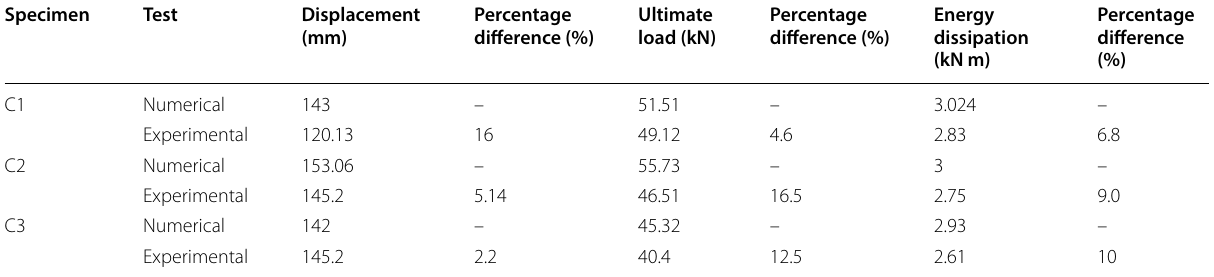
Table 9 Comparison of numerical and test results at top of the columns (C1, 2 and 3)